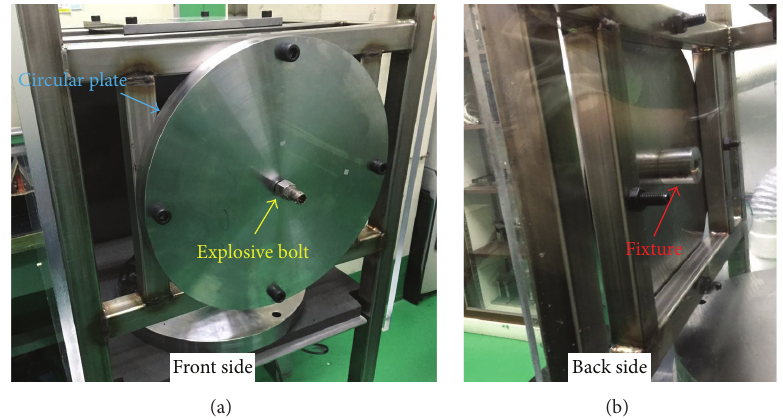
Figure 3: Pyroshock measurement structure setup using a fixture and a circular plate, (a) front side and (b) back side.